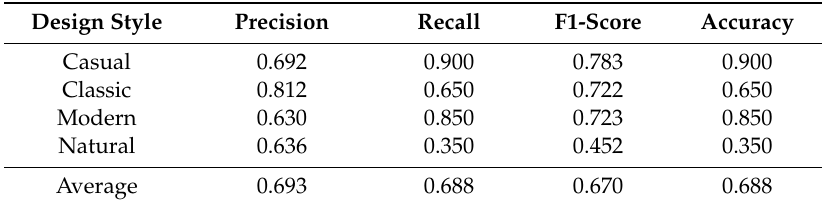
Table 4. Precision, recall, and F1-score measures for evaluating the design style detection model according to each design style.